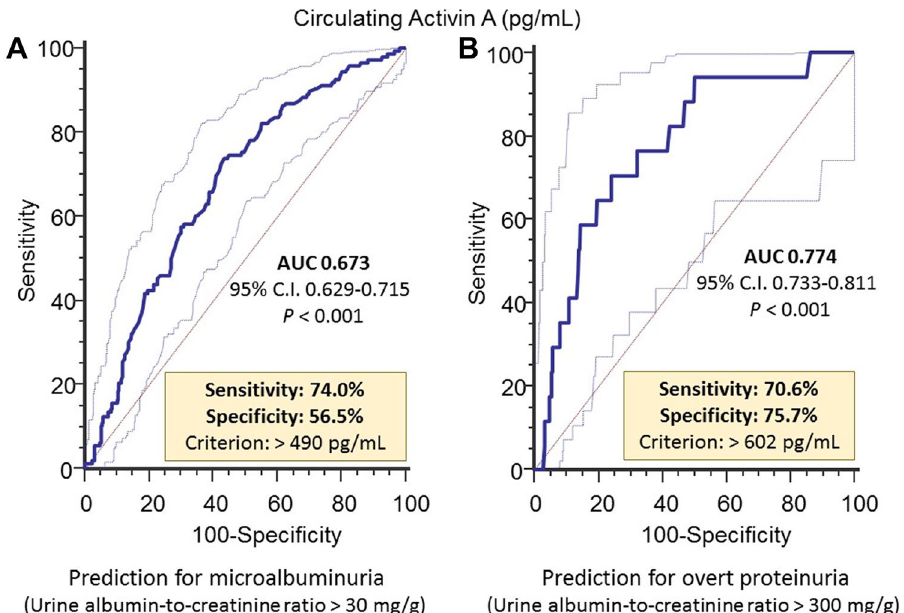
Figure 3. A receiver operating characteristic curve analysis between circulating activin A level and ( A ) microalbuminuria (urine albumin-to-creatinine ratio > 30 mg/g), ( B ) overt albuminuria (urine albumin-to- creatinine ratio > 300